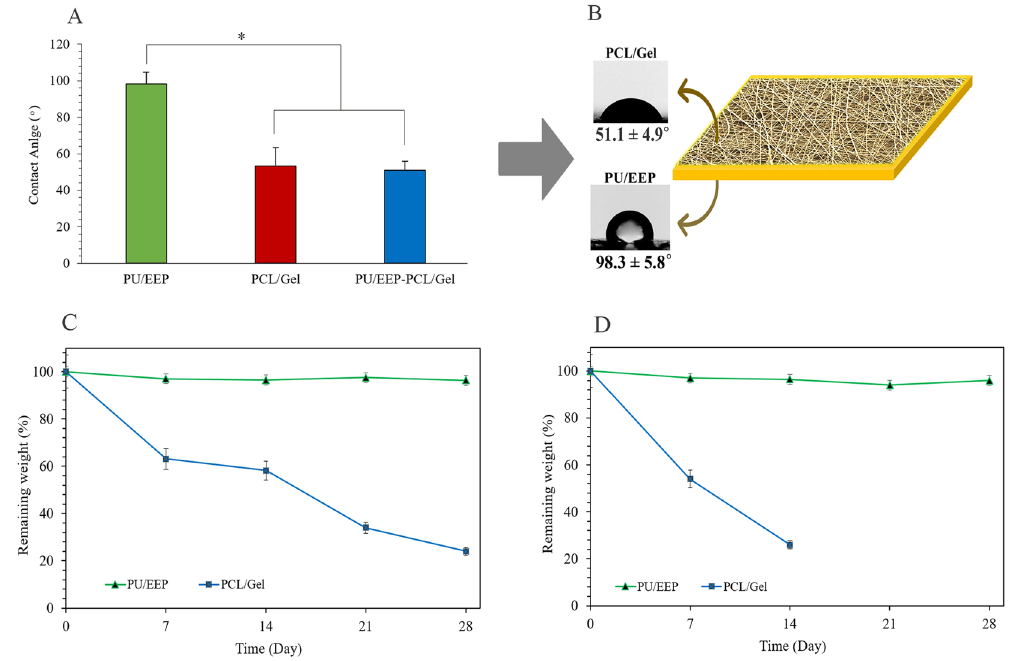
Figure 6. ( A ) The water contact angles of the top layer, the sublayer, and the bilayer wound dressing. ( B ) Schematic illustration of water contact angels of the toplayer and sublayer of the bilayer wound dressing. ( C ) The hydrolytic and ( D ) enzymatic degradation of the PU/EEP membrane (top layer) and the PCL/Gel scaffold (sublayer). Data are expressed as mean ± SD (n =